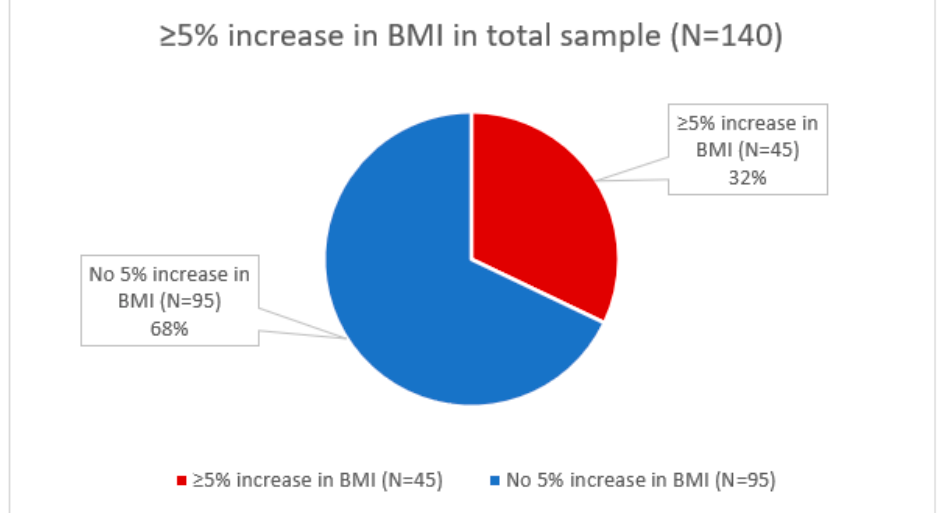
Figure 3. Prevalence of at least 5% increase in BMI from date of diagnosis to most recent follow-up.